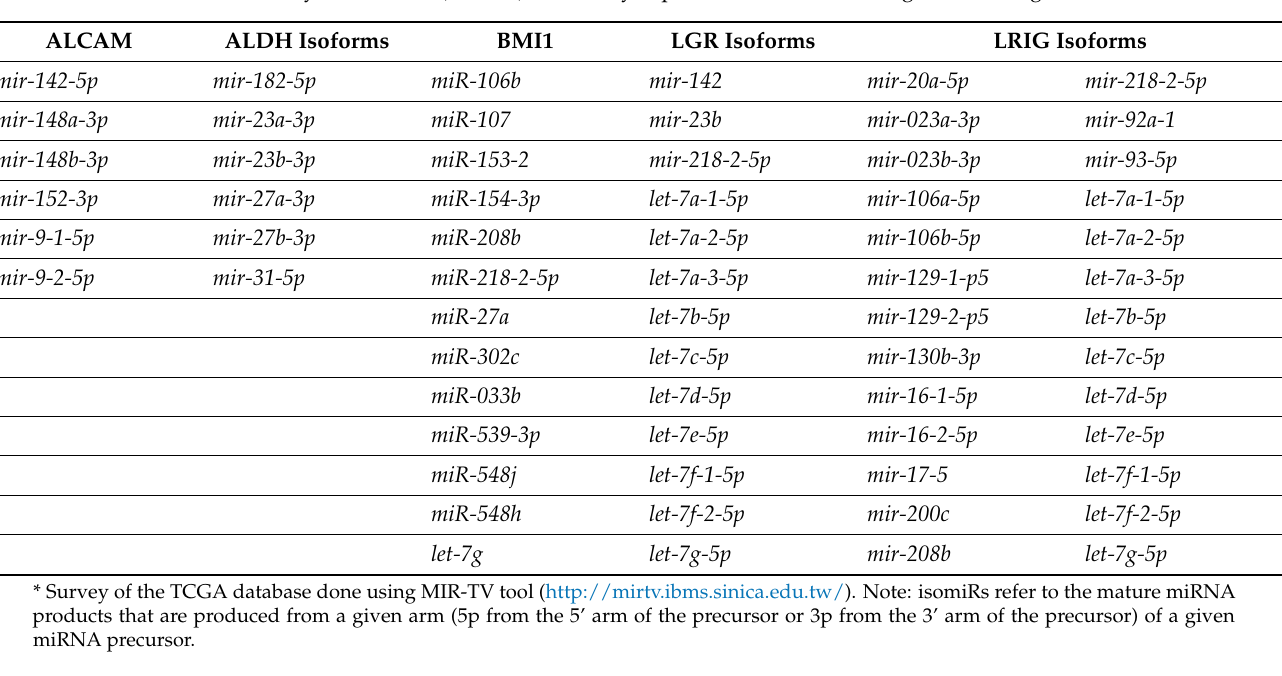
Table 1. Survey of miRNAs ( n = 216) aberrantly expressed in CRCs that target stem cell genes *.